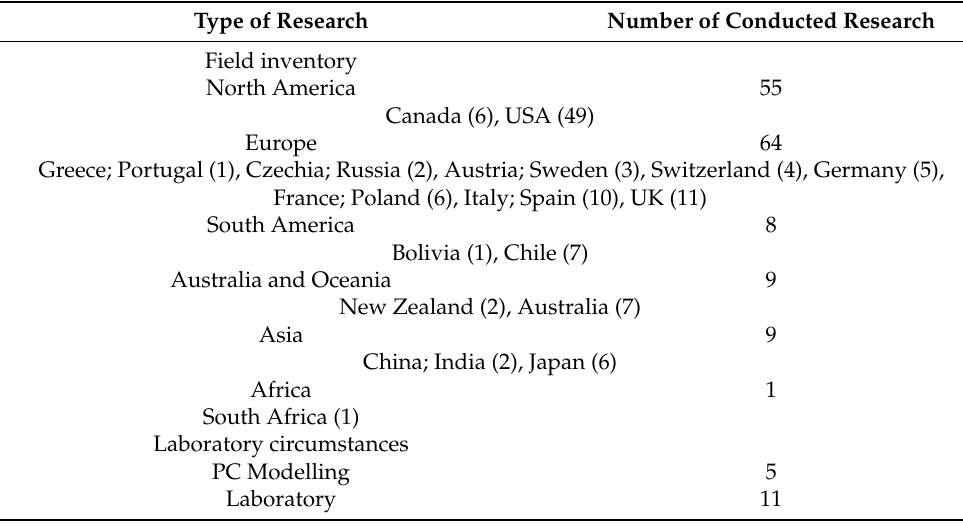
Table 4. Geographical distribution of research sites